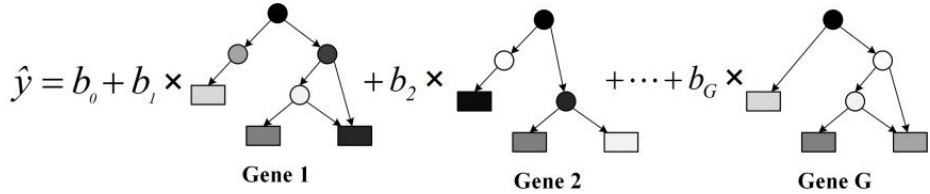
Figure 7. Schematic diagram of symbolic regression modeling.